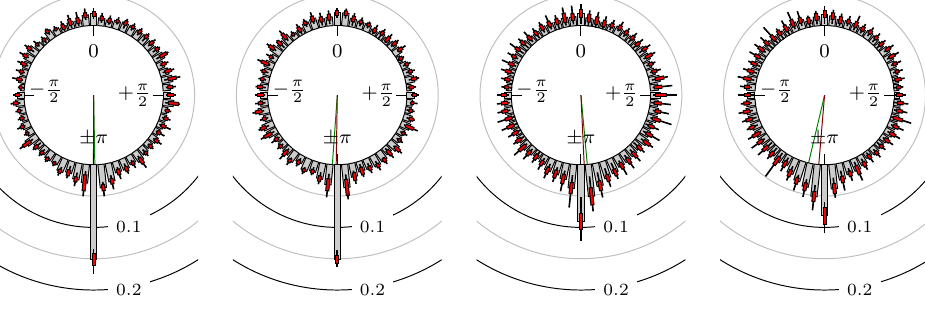
Figure 11. DAX versus BUND.